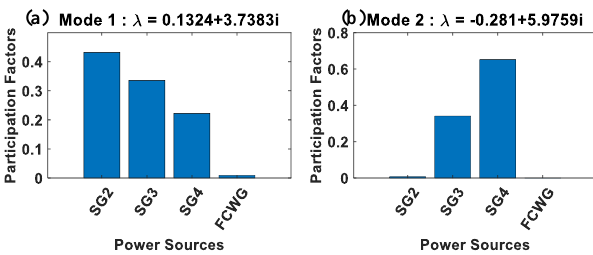
Figure 14. Weak interaction case: participation of power sources in EOMs when SG1 is replaced with FCWG: ( a ) closed-loop Mode 1; ( b ) closed-loop Mode 2.